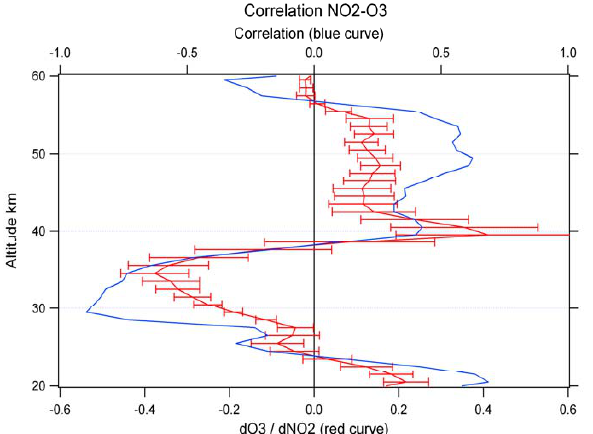
Fig. 32: Correlation between the deviation of NO 2 and O 3 from their mean seasonal values at the same altitude (blue curve) and relative variation of O 3 per unit relative variation of NO 2 (red curve) (from Hauchecorne et al., 2010).